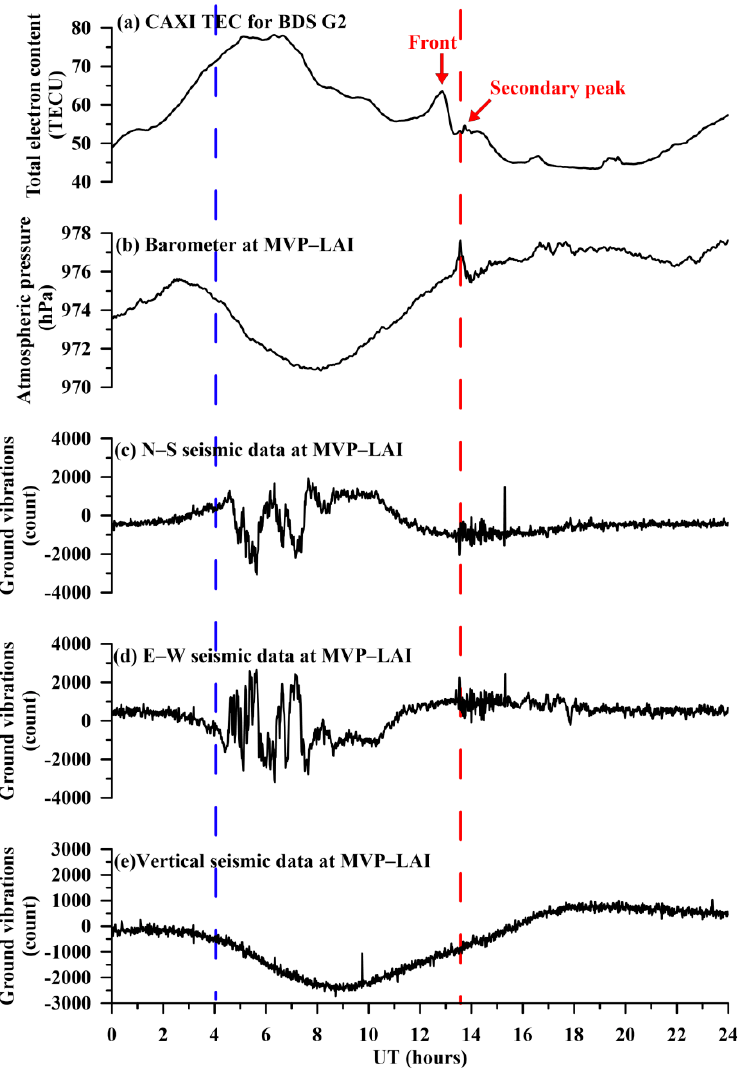
Figure 3. Variations in the CAXI sTEC, air pressure, and ground vibrations in the MVP-LAI system on 15 January 2022: ( a , b ) show the variations in the CAXI sTEC and the air pressure, respectively. ( c – e ) exhibit the ground vibrations in the NS, EW, and vertical components. The blue vertical dashed line indicates the occurrence time of the underwater volcano eruption. The red vertical dashed line indicates the arrivals of perturbations in the troposphere. The two arrows mark the front and the secondary peak of TEC perturbations in the ionosphere associated with the volcano eruption.